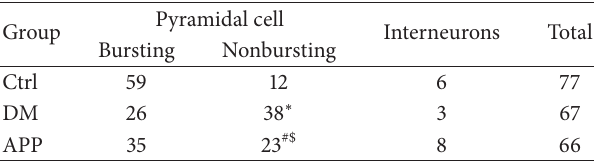
Table 1: Number of different types of cells recorded from CA1 in the three groups. Pyramidal cell Group Interneurons Total Bursting Nonbursting Ctrl 59 12 6 77 DM 26 38 ∗ 3 67 APP 35 23 #$ 8